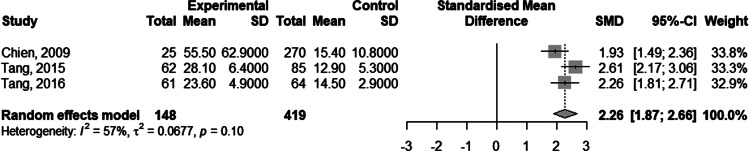
Forest plot of the duration of recovery from anti-TB DILI in HBV carriers compared to non-carriers.